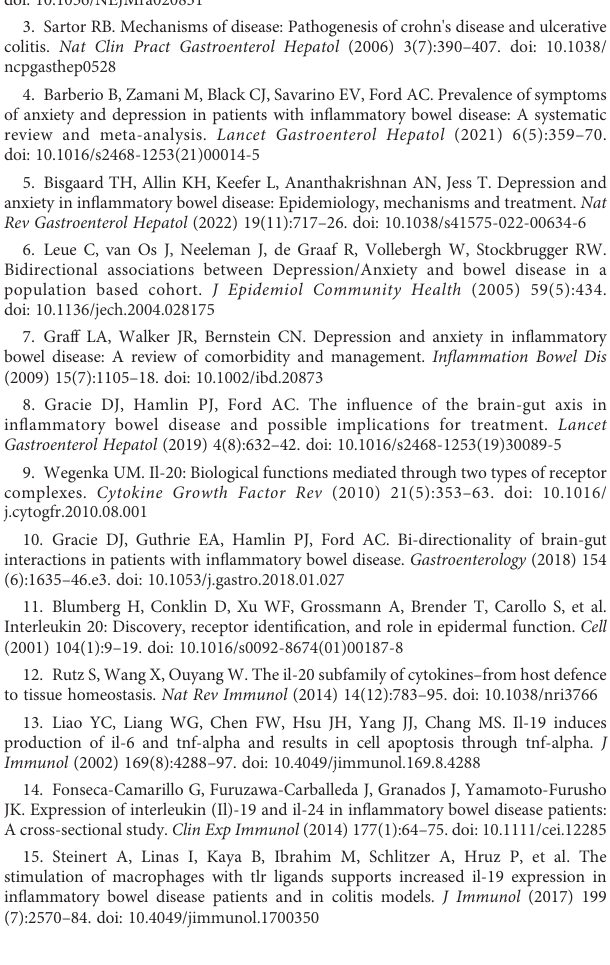
SUPPLEMENTARY FIGURE 1 The GAD7 scores and its relation to GIQLI score of IBD patients. (A) GAD7 scores. (B) Correlation analysis of GAD7 scores and GIQLI score of IBD